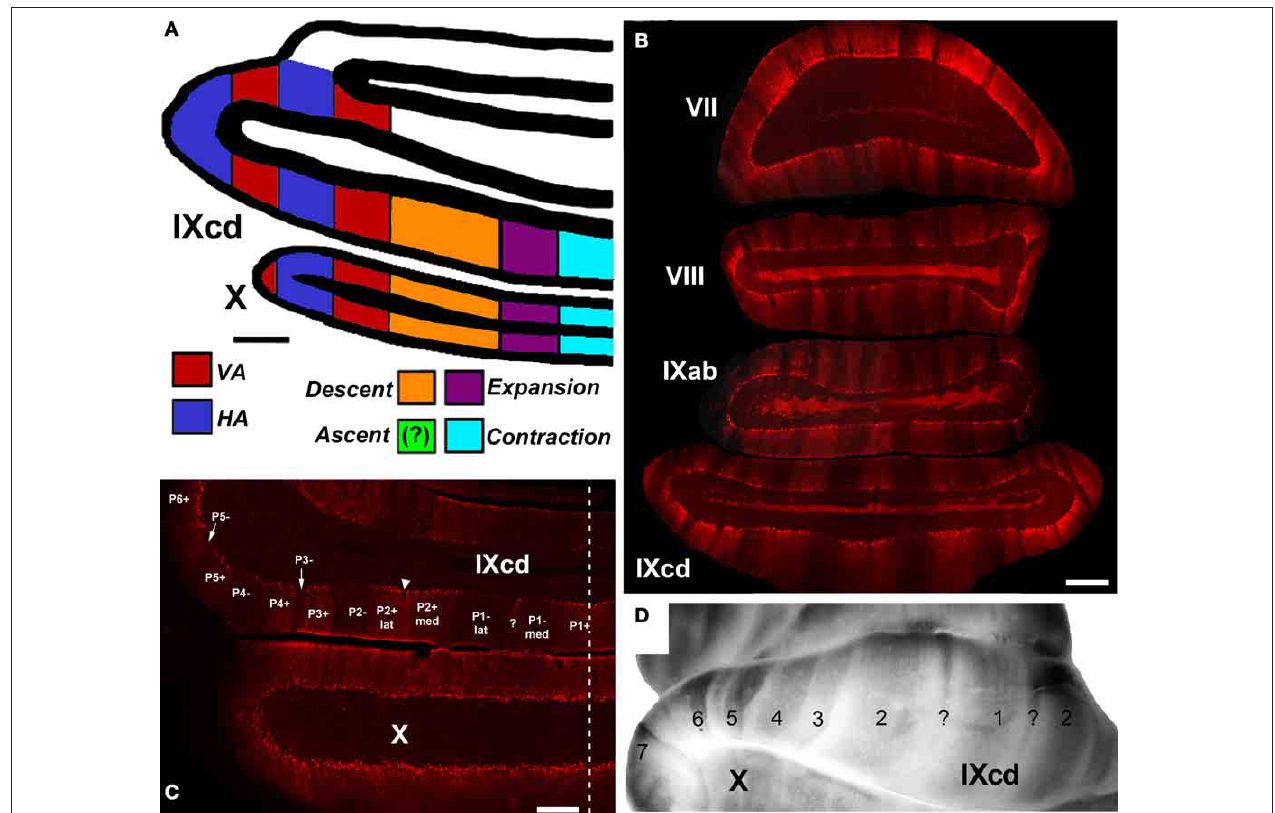
FIGURE 8 | (A) Shows a schematic of the zonal organization of the optic flow responsive cells in the VbC as concluded from a series of electrophysiological and anatomical studies (Wylie and Frost, 1993, 1999b; Wylie et al., 1993, 2003a,b; Winship and Wylie, 2003; Pakan et al., 2005). The location of the Ascent units was unknown. (B) Shows a coronal section through the posterior cerebellum (folia VII–IXcd) showing heterogeneous zebrin II (ZII) expression. (C) and (D) Highlight the ZII expression in the vestibulocerebellum. (D) Is a wholemount of the cerebellum whereas (C) is a coronal section through folia IXcd and X. The ZII stripes are numbered P1 ± to